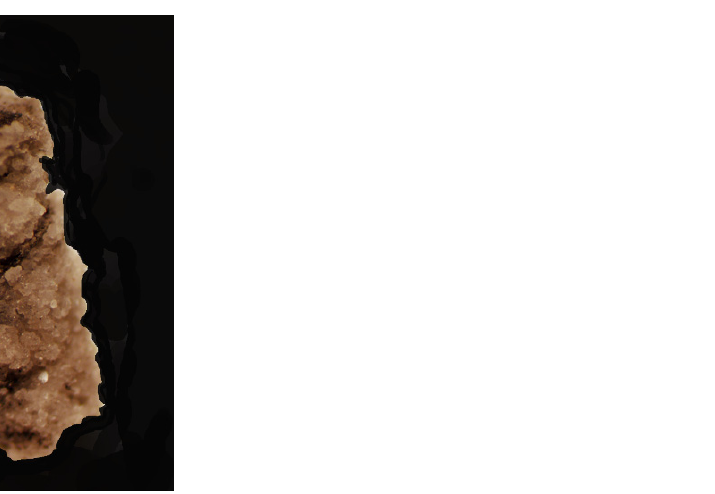
Figure 8. Abyssochrysoid gastropod (IGM 5010b). This view shows the last whorl separating slightly from the previous whorl, forming a channel.